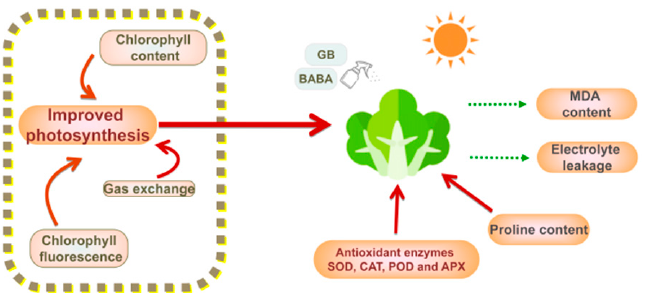
Figure 4. Schematic summary of GB- and BABA-primed physiological status for the preadaptation to heat stress in Chinese Cabbage seedlings. The solid arrows represent enhancement, whereas the dotted arrows represent inhibition.